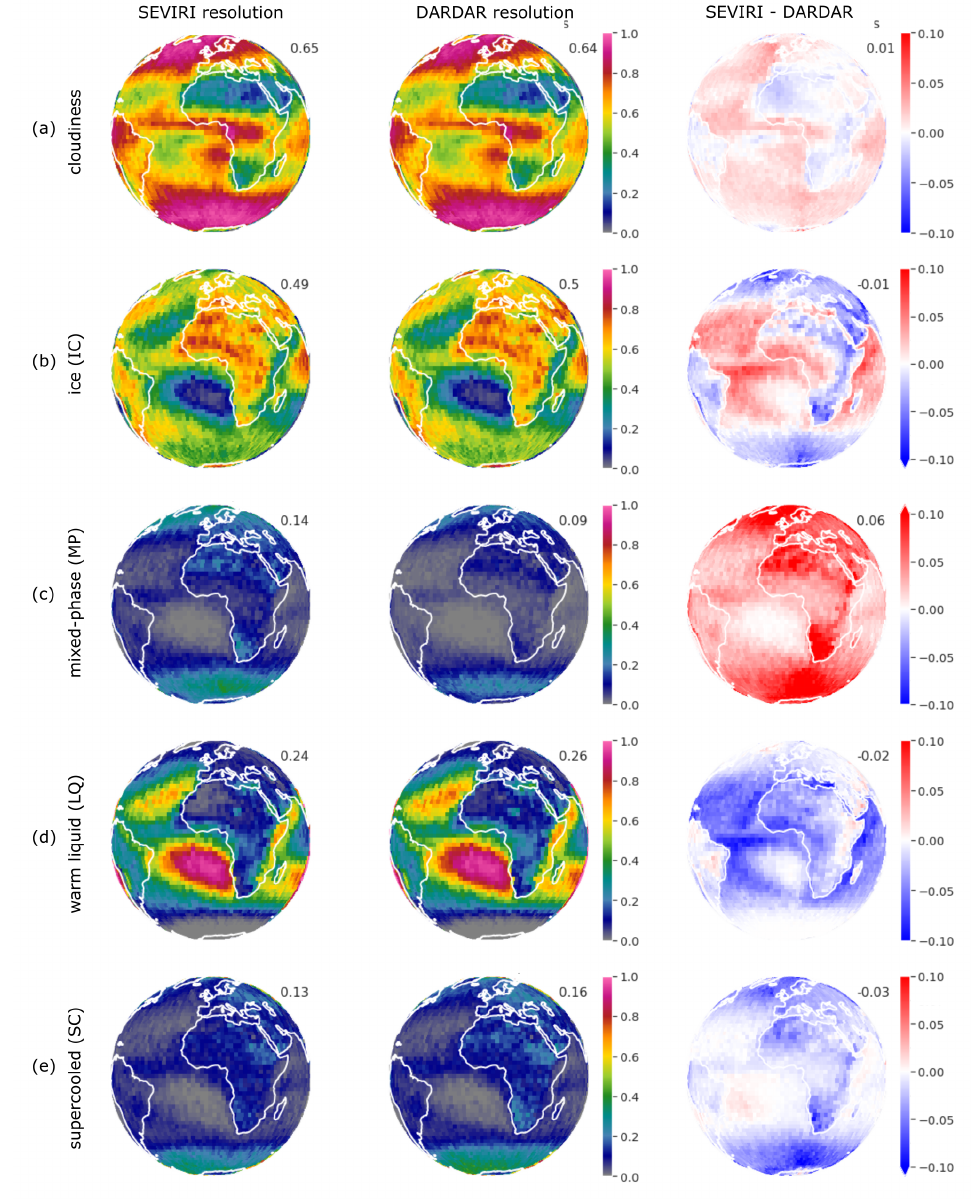
Figure 3. ( a ) Cloudiness and ( b – e ) phase occurrence for the CTPs IC (ice), MP (mixed-phase), LQ (liquid), and SC (supercooled) for SEVIRI resolution (left column), DARDAR resolution (middle column) and the difference SEVIRI minus DARDAR (right column). Boxes of 2.5 ◦ latitude by 2.5 ◦ longitude are used for all